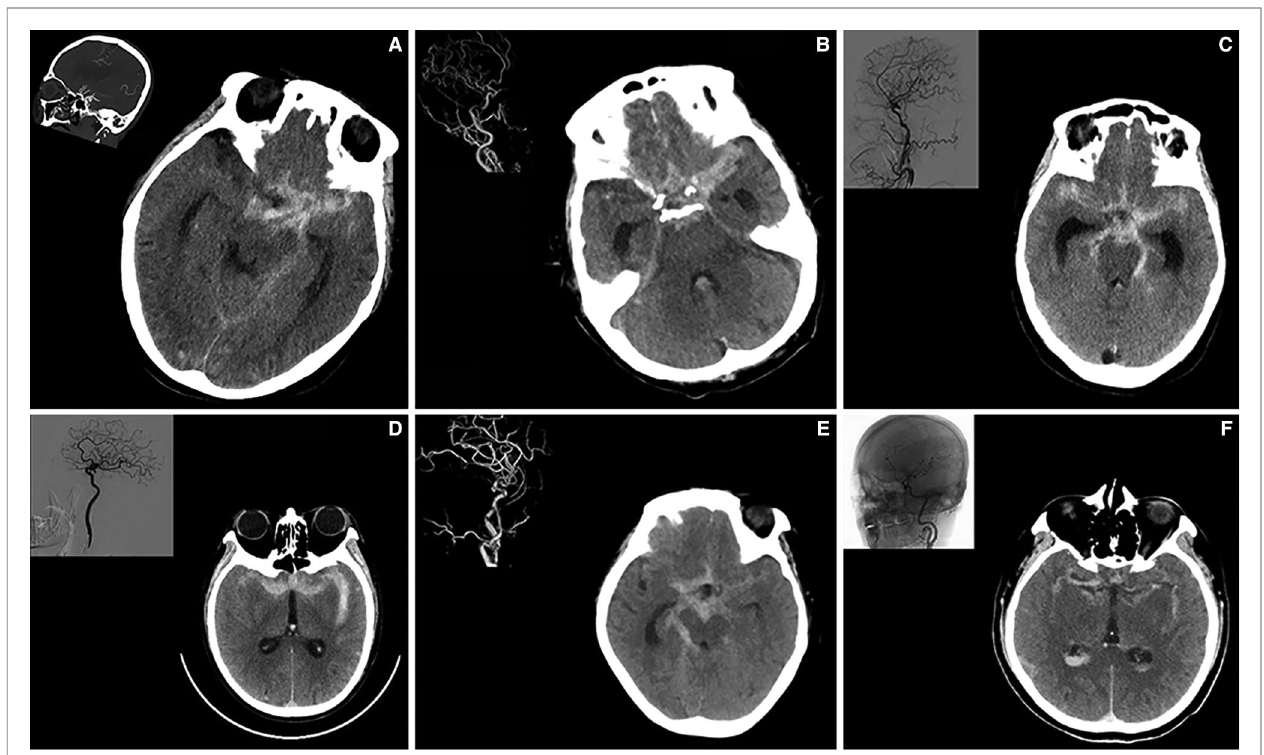
FIGURE 1 | A high modi fi ed Fisher grade predicts the development of “ typical ” symptoms ” in elderly patients with ruptured IA. Part A – F illustrated 6 individual cases of elderly patients showing increased subarachnoid hemorrhage and expanded subarachnoid spaces. Digital subtraction angiography of related patients was shown on the left upper